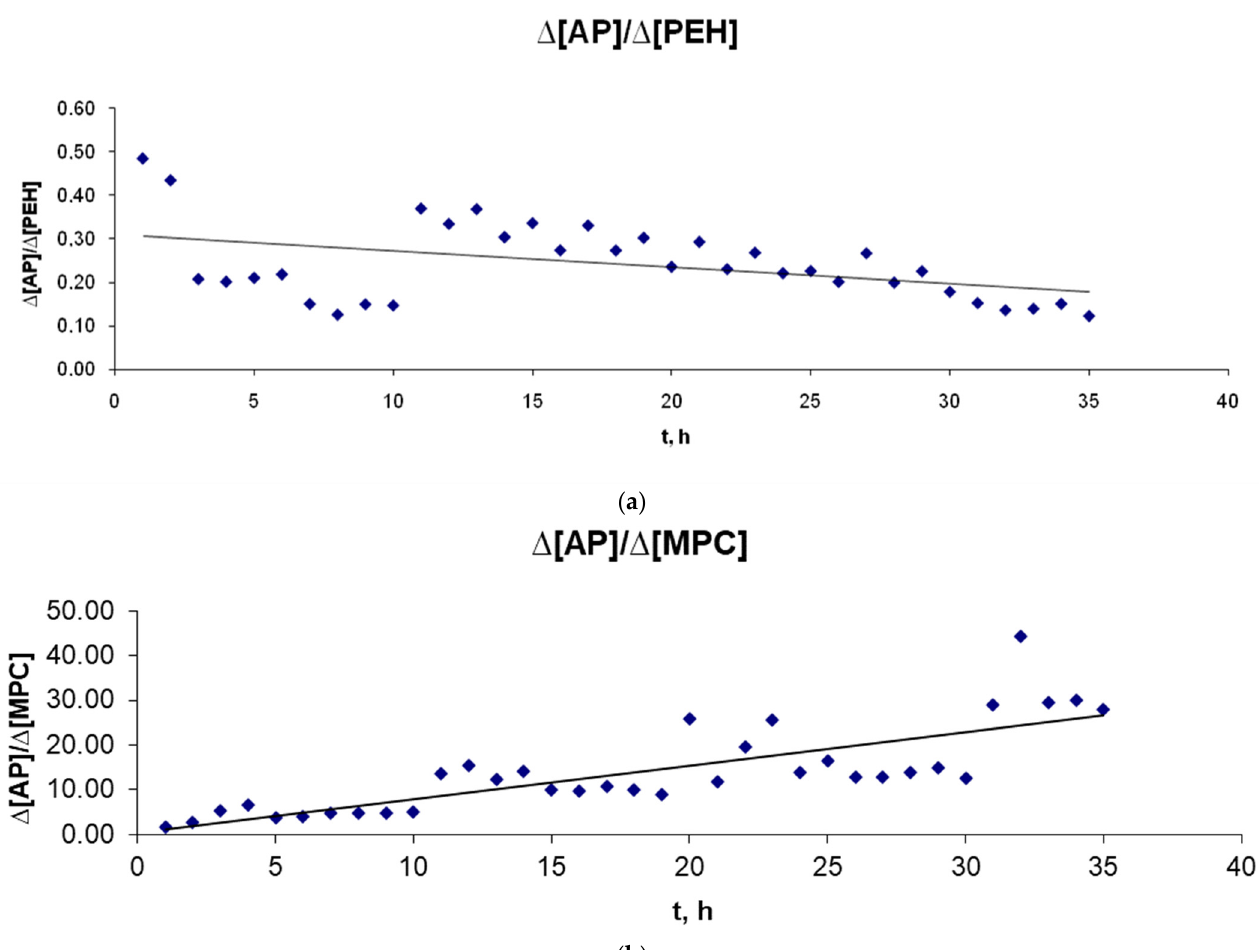
Figure 2. The ratio of the concentrations of oxidation products Δ [AP]]/ Δ [PEH] ( a ) and Δ [AP]/ Δ [MPC] ( b ) versus time t (h) in the oxidation reaction of ethylbenzene catalyzed by complexes {Ni(acac) 2 ∙ NaSt ∙ PhOH}, at 120 °C.